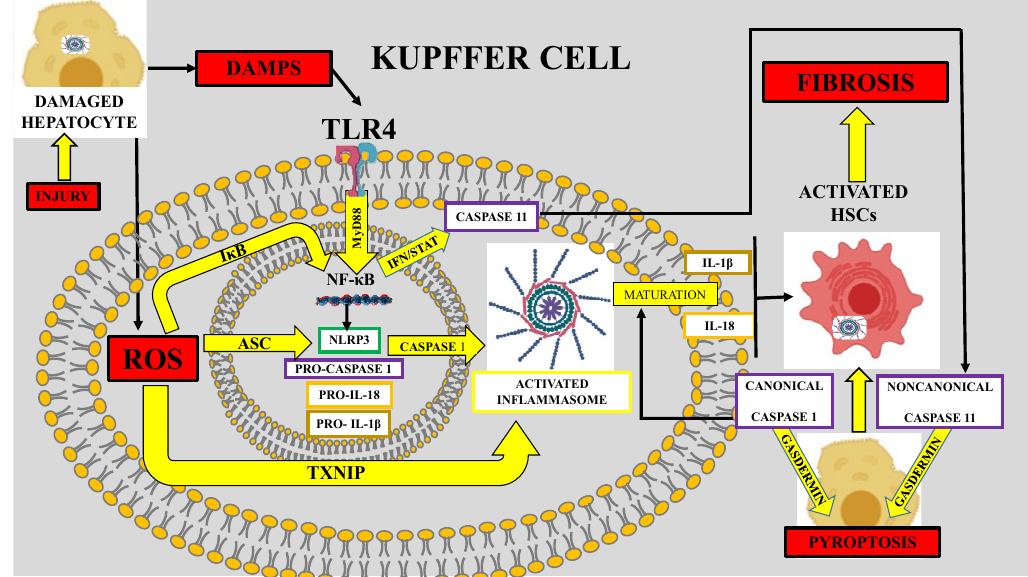
Figure 3. Reactive oxygen species (ROS) trigger fibrosis via several inflammatory pathways. Alcohol, viruses, or other toxic stimuli may injure hepatocytes, which release ROS and damage-associated molecular patterns (DAMPs) that bind to Toll-like receptor 4 (TLR4) in Kupffer cells. Then, the TLR4/MyD88 pathway activates nuclear factor- κ B (NF- κ B), which triggers the inflammatory response by promoting the transcription of the nucleotide-binding oligomerization domain (NOD)-like receptor protein 3 (NLRP3), pro-caspase-1, pro-IL-18, and pro-IL-1 β . NLRP3 induces the maturation of caspase 1, which in turn triggers inflammasome activation mediated by ROS and apoptosis-associated speck-like protein containing a caspase recruitment domain (ASC); inflammasome activation induces the maturation of IL-1 β and IL-18, which promote the activation of hepatic stellate cells (HSCs). ROS can activate the inflammasome through the thioredoxin-interacting protein (TXNIP) signaling pathway. NF- κ B may promote caspase 11 upregulation via the IFN/STAT pathway. Caspase 1 and caspase 11 can induce pyroptosis via gasdermin by canonical or noncanonical pathways, respectively. Pyroptosis induces the activation of HSCs. ROS may promote NF- κ B activation via the dissociation of the inhibitory factor I κ B. Importantly, the activation of HSCs by any mechanism results in liver fibrosis.